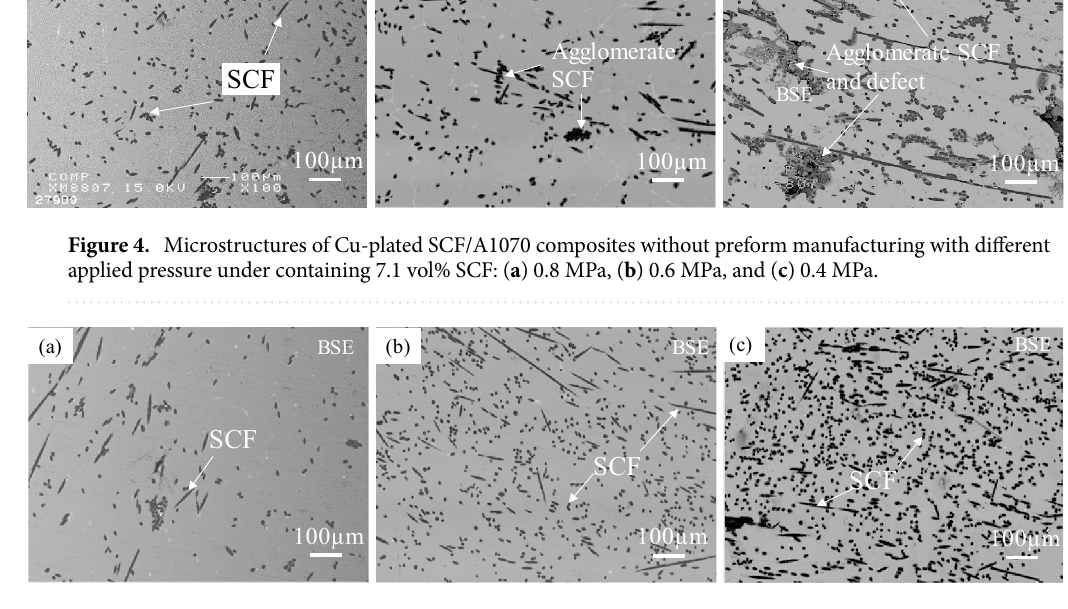
Figure 5. Microstructures of Cu-plated SCF/A1070 composites without preform manufacturing with different volume fraction of SCF under pressure of 0.8 MPa: ( a ) 7.1, ( b ) 14.3, and ( c ) 29.1